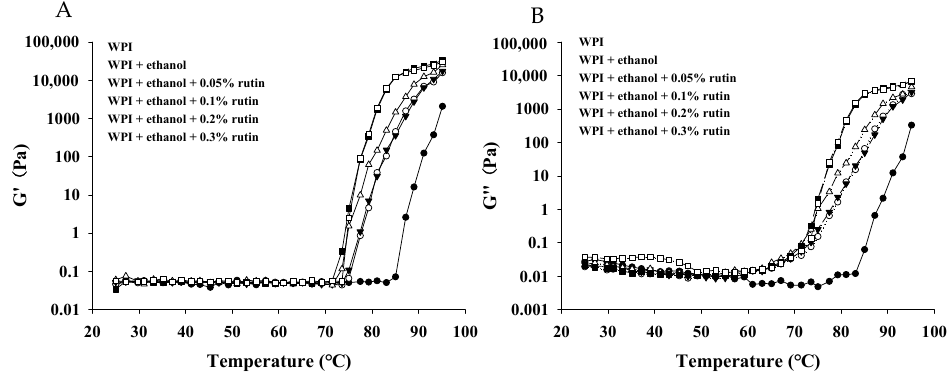
Figure 7. The effects of ethanol (15% v / v ) and different levels of rutin (0.05%, 0.1%, 0.2% and 0.3% w / v ) on the storage modulus (G (cid:48) ) ( A ) and loss modulus (G (cid:48)(cid:48) ) ( B ) of